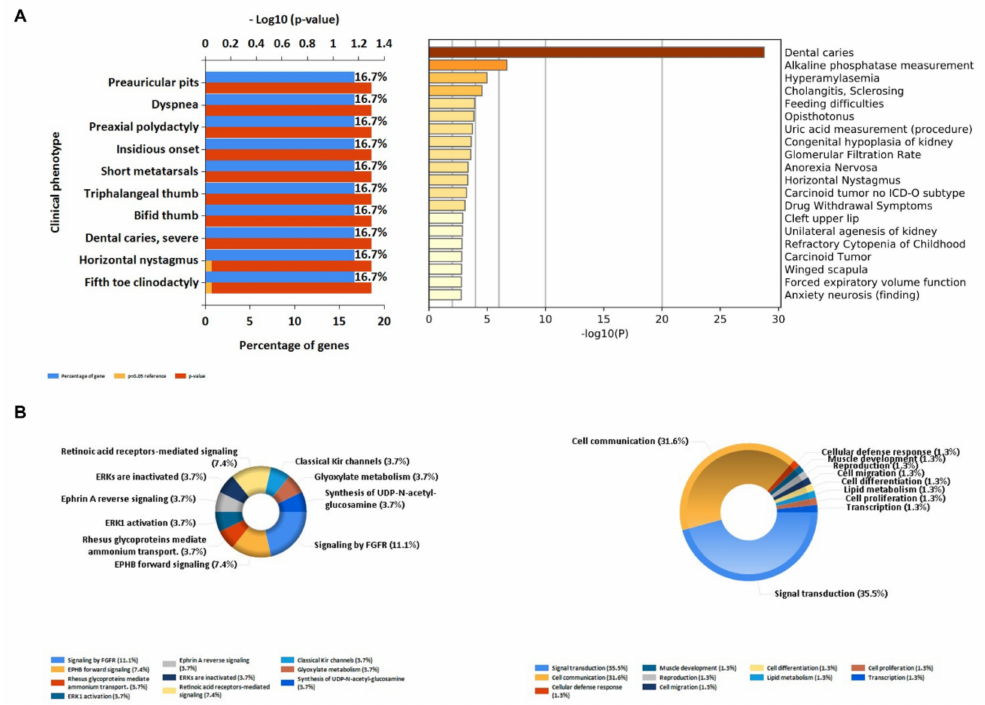
Figure 5. Dental-caries- and periodontitis-related genes’ functional annotation: ( A ) the clinical phenotypes of the related genes; ( B ) the biological pathways and processes of the related genes.